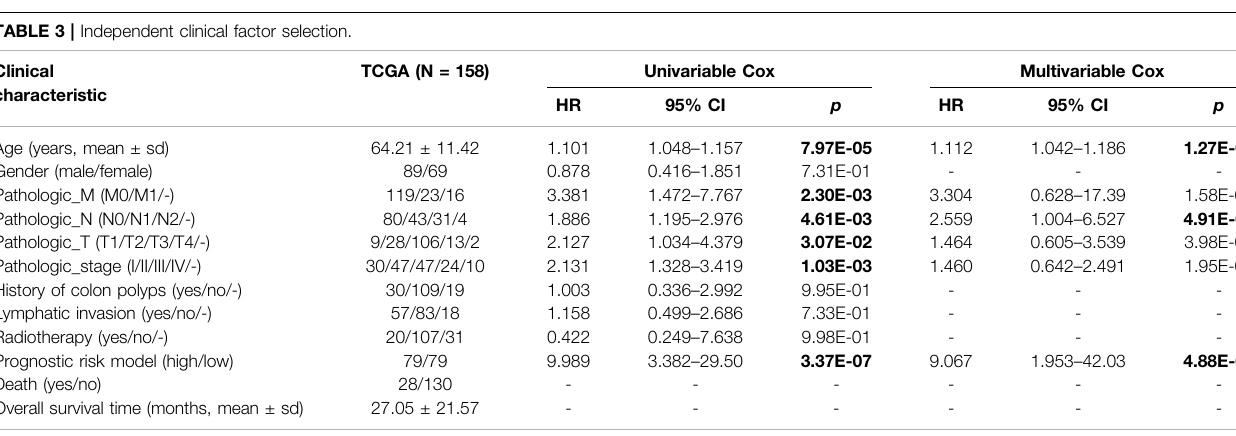
TABLE 3 | Independent clinical factor